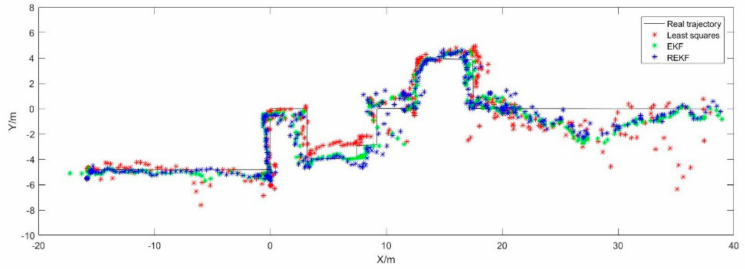
Figure 13. The motion trajectories of the pedestrian calculated with three